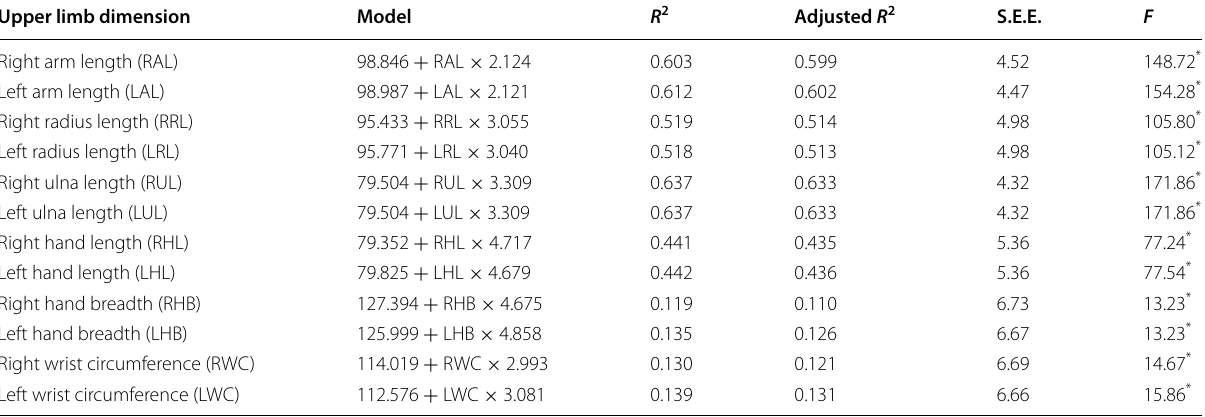
S.E.E. standard error of the estimate * Significant at P < 0.01